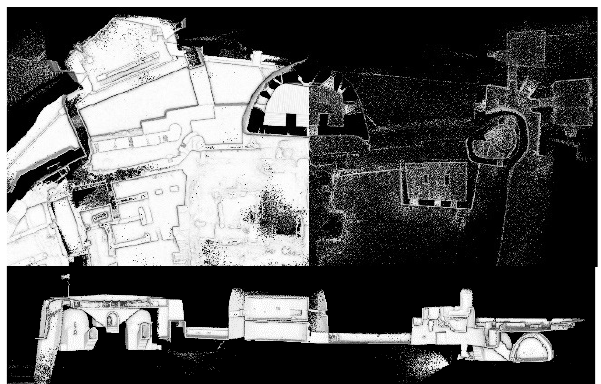
Figure 4. SLAM Point Cloud of the interior and exterior of the bastion of Qal'at al- Bahrain . Source: authors and BACA.